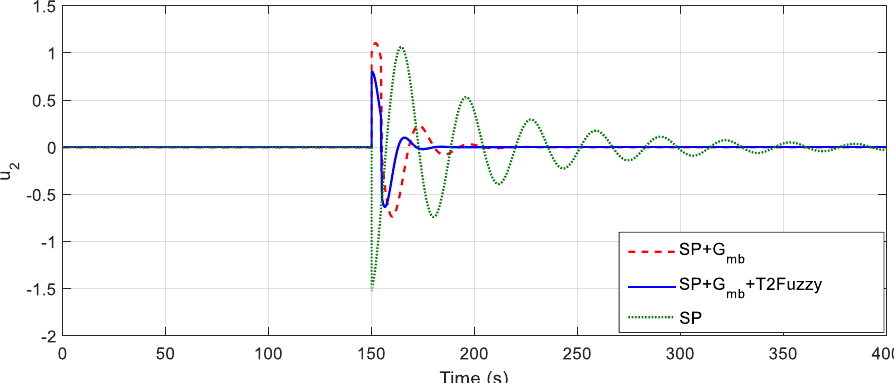
Figure 13. The control signal 𝑢 1 for all three methods by applying disturbance.